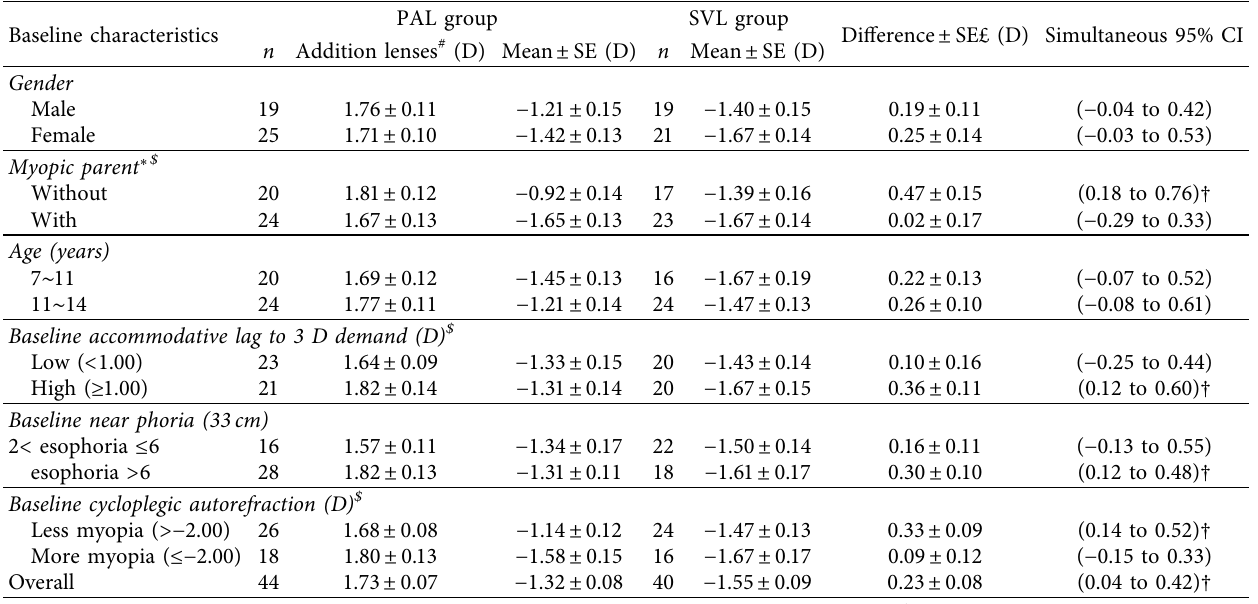
Table 2: Adjusted 2-year myopia progression and mean difference between study groups defined by baseline characteristics. Baseline